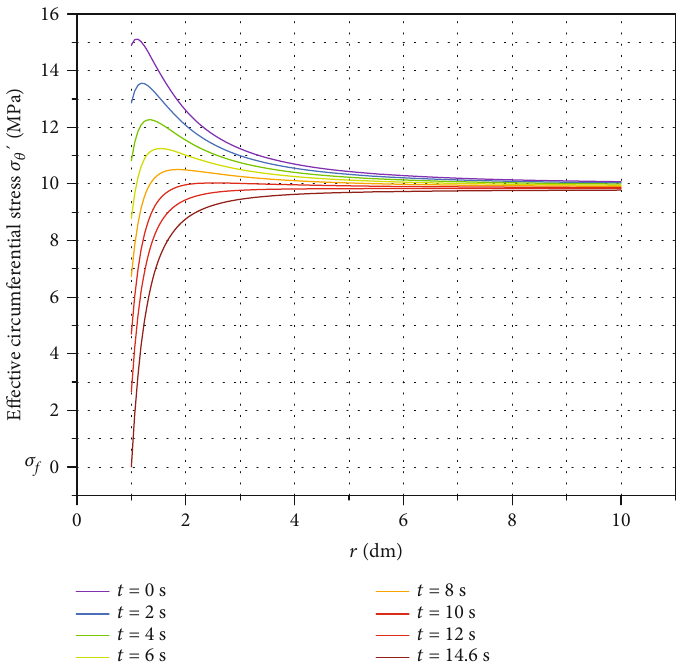
′ with radial distance for impermeable rock. θ